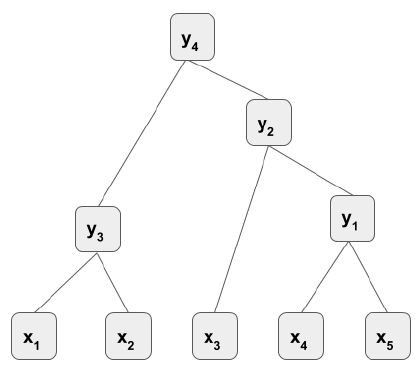
Figure 5. A greedy recursive